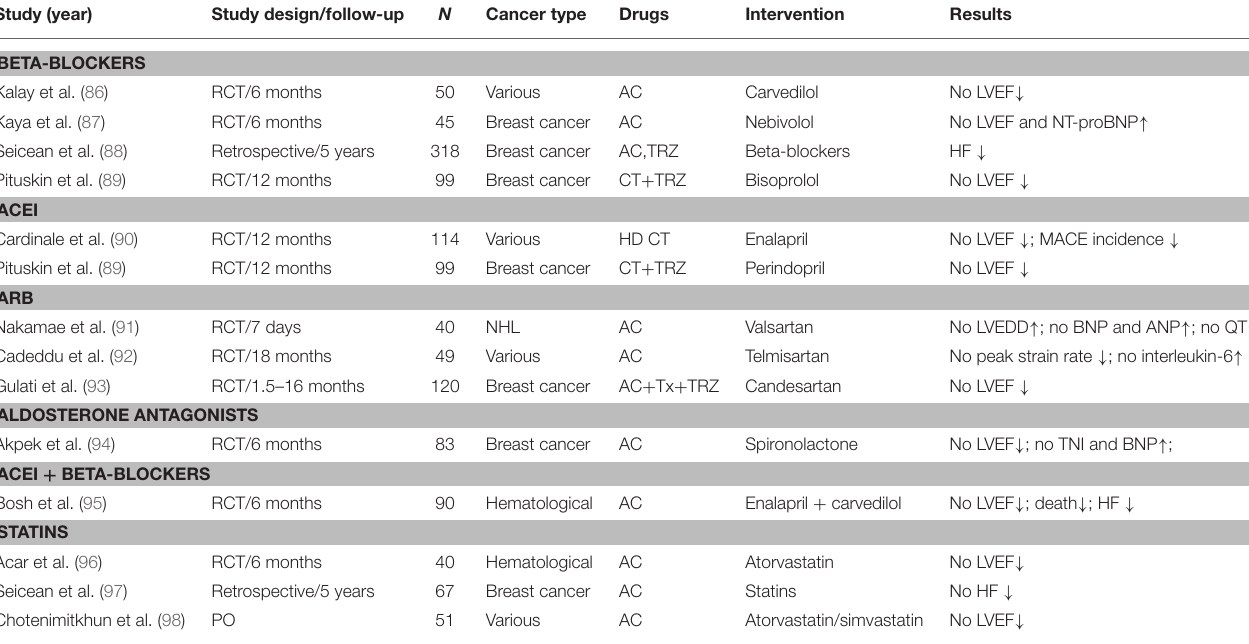
TABLE 4 | Cardiovascular drugs showing a prophylactic effect against anticancer therapy-induced LVD in adult cancer